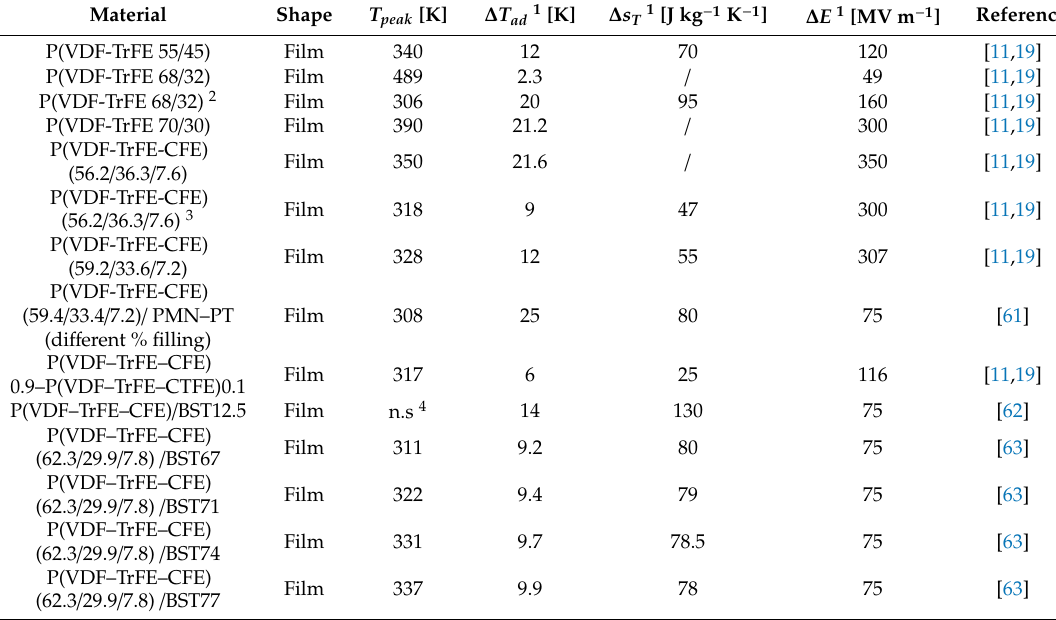
Table 3. Ferroelectric polymers and their electrocaloric